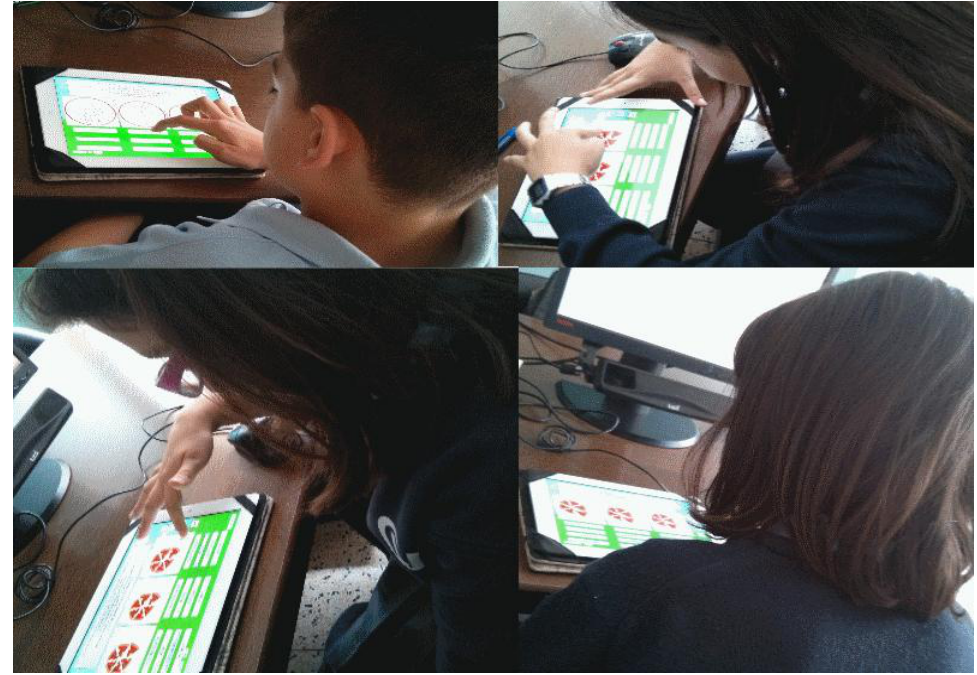
Figure 7. Children evaluating the game.